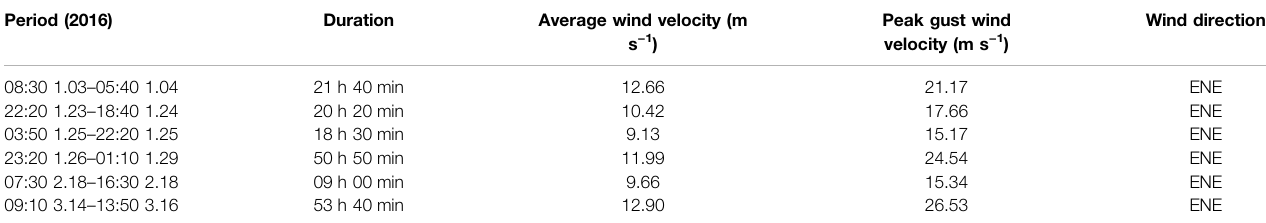
TABLE 1 | Basic information for the six sandstorms that occurred during the observation period (January to March 2016) to collect sand transport data (the wind data was obtained from a meteorological station (Gill MaxiMet GMX600), located approximately 1 km northeast of the observation site; both wind velocity and direction were measured at a height of 2.0